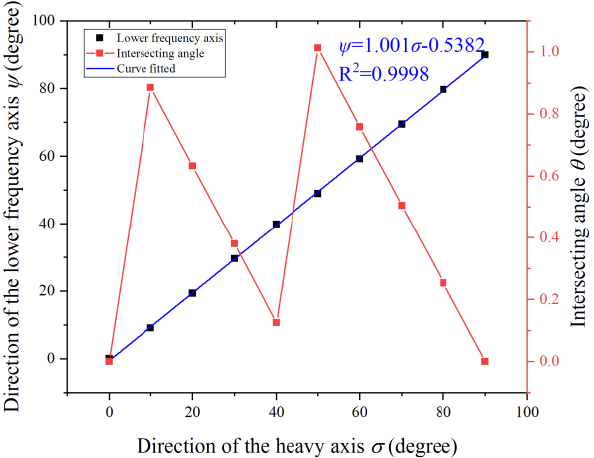
Figure 11. Relation between the heavy axis and the low-frequency axis of the n = 1 mode.